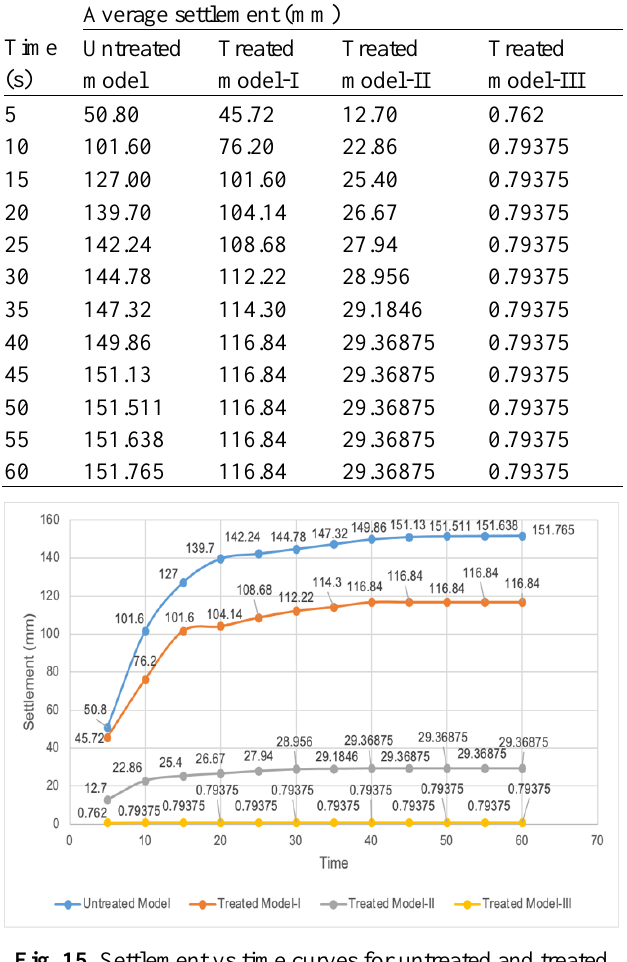
Fig. 15. Settlement vs time curves for untreated and treated models